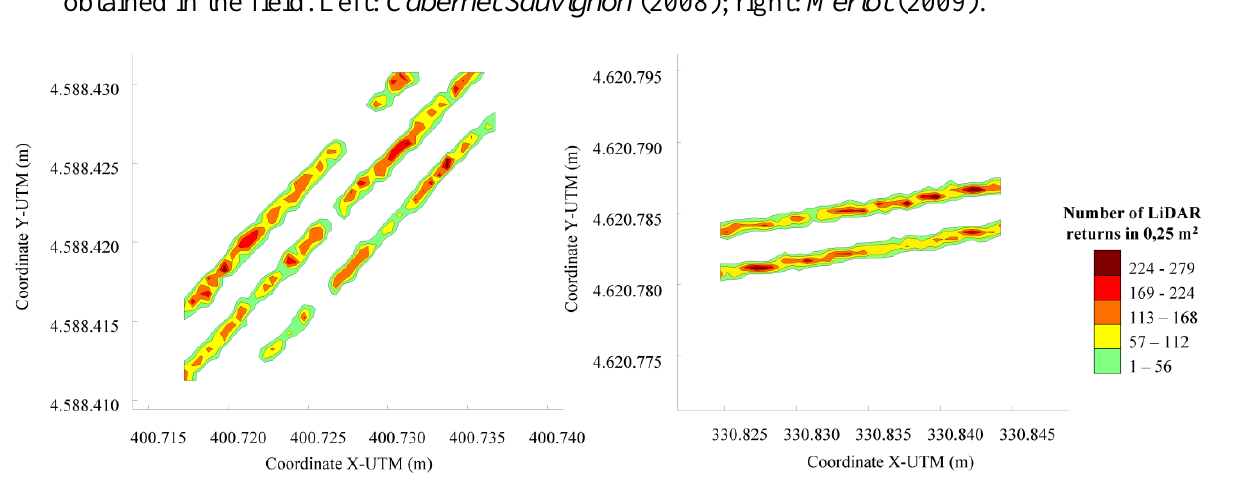
Figure 10. Georeferenced density map obtained after LiDAR measurement process on the field. Intervals have been defined according minimum and maximum LiDAR returns·cm −2 obtained in the field. Left: Cabernet Sauvignon (2008); right: Merlot